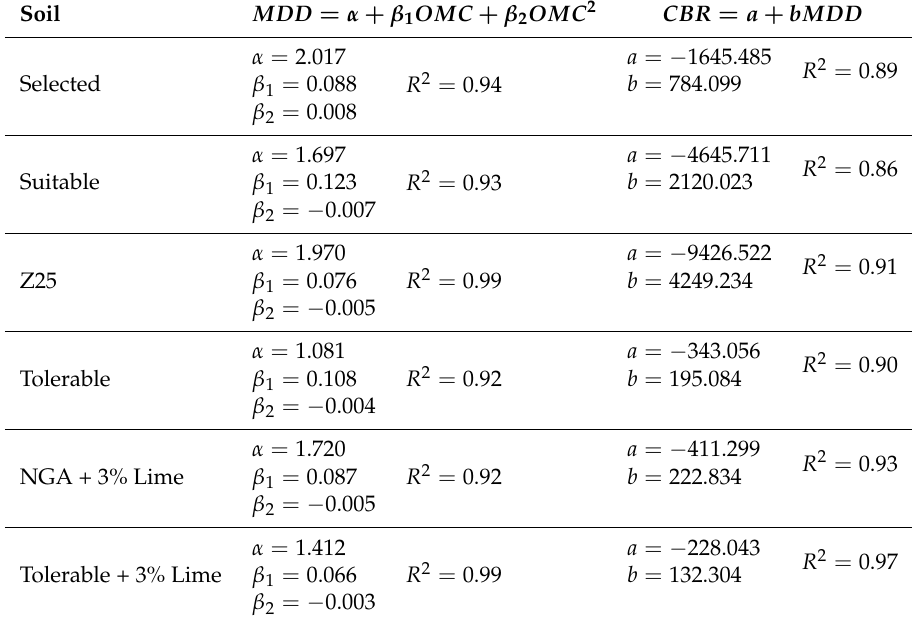
Table 5. Summary of analytical correlation between CBR and